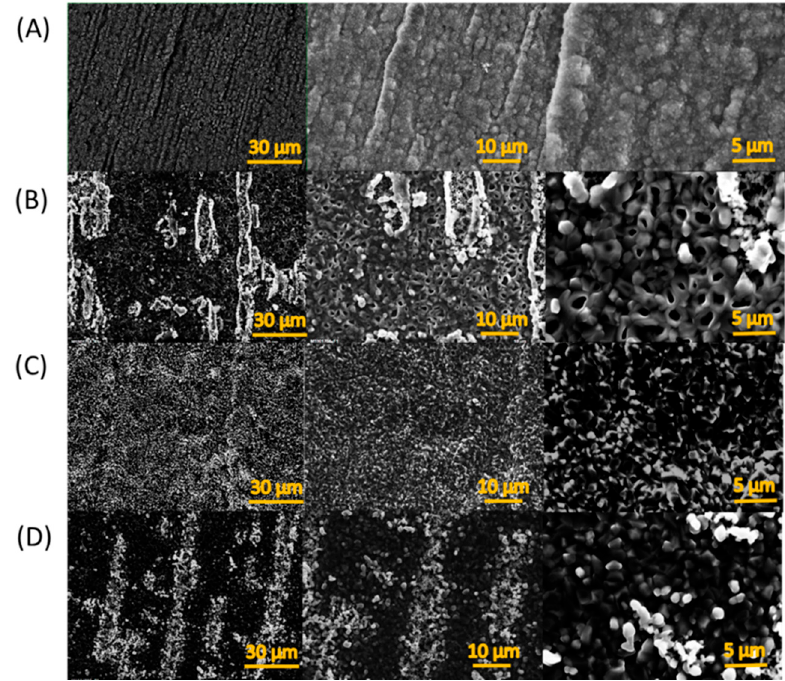
Figure 7. SEM enlarged images for ( A ) uncoated AISIS steel ( B ) sample A1 ( C ) sample A2 ( D ) sample ◦ C for 300 A3 after oxidation heat treatment at 800 °C for 300 h. A3 after oxidation heat treatment at 800